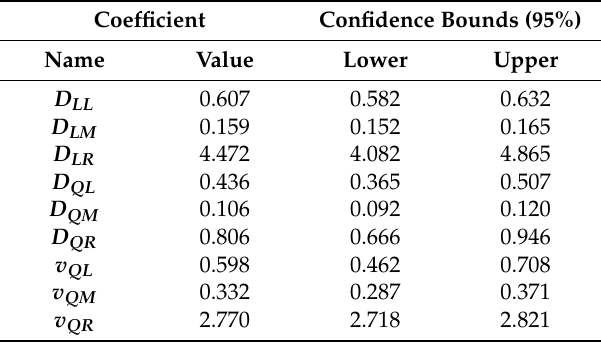
Table 3. Computed coefficients for the linear and quadratic fits of the MSD Equations (11) and (12).